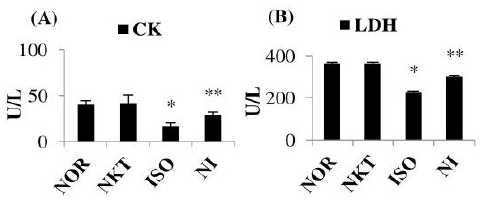
Figure 2. Effect of NKT on cardiac markers: concentrations of ( A ) creatine kinase (CK) and ( B ) lactate dehydrogenase (LDH) in the myocardium. Each column is the mean ± standard error of the mean (SEM) for eight rats in each group; * p < 0.05 as compared to the normal control (Group-I), ** p < 0.05